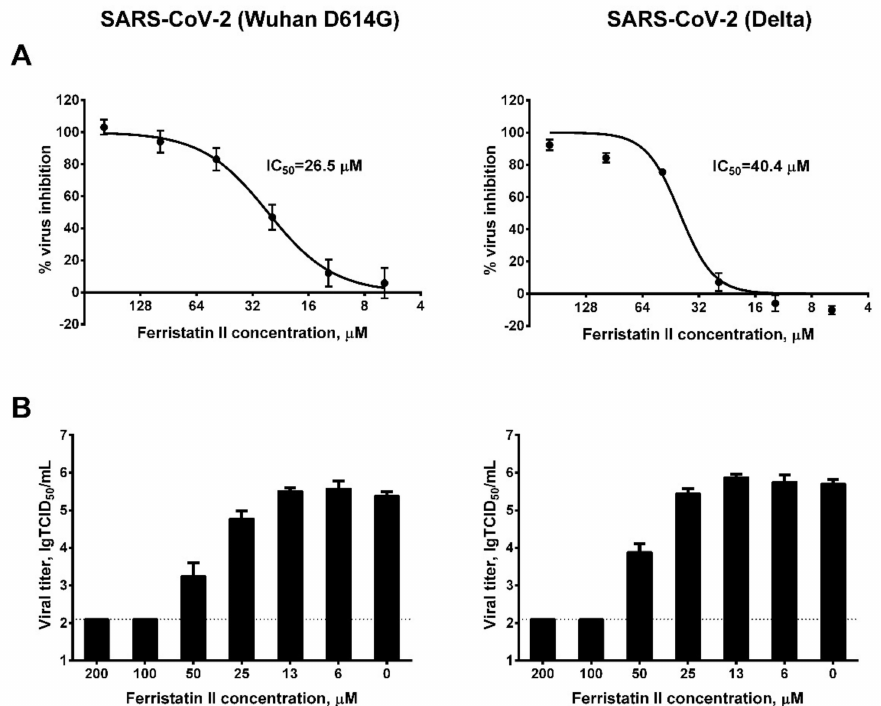
Figure 2. Inhibition of SARS-CoV-2 replication in Vero cells by ferristatin II. ( A ) Assessment of the levels of virus neutralization by the detection of RBD antigen in the cells by cell-based ELISA. ( B ) Assessment of viral titers in cell supernatants by quantitative real-time RT-PCR. The dotted line represents the limit of viral RNA detection. IC 50 : 50% inhibiting concentration. Data are presented as the mean ± SD ( n = 3).